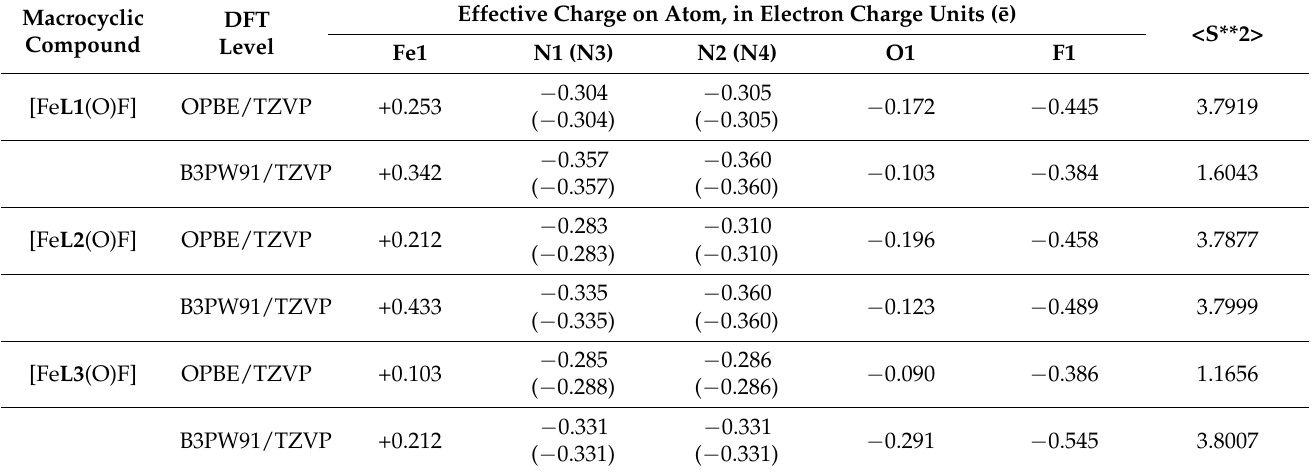
Table 2. NBO analysis data for the iron compounds [Fe L1 (O)F], [Fe L2 (O)F] and [Fe L3 (O)F] calculated by the DFT B3PW91/TZVP and DFT OPBE/TZVP